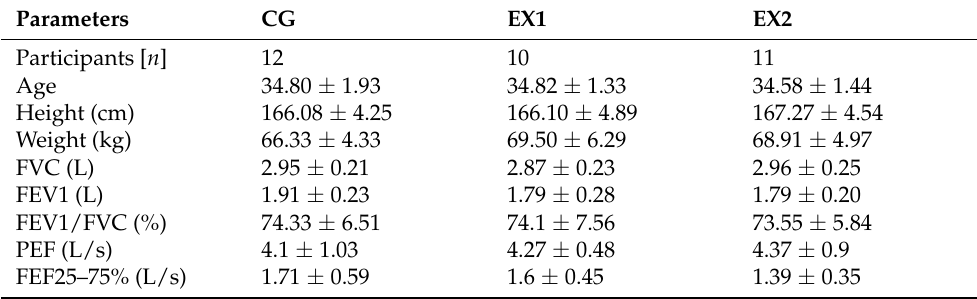
Table 1. Initial